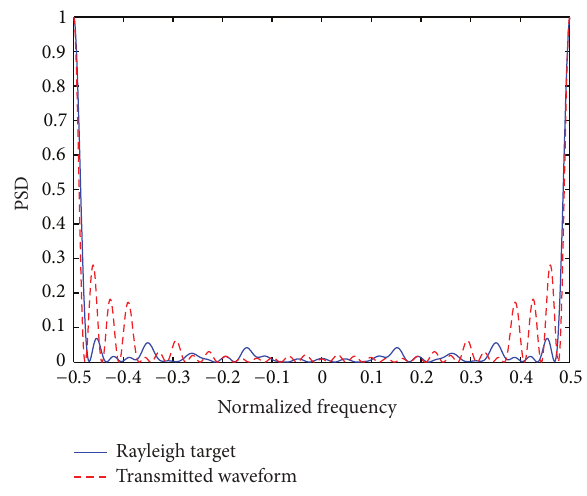
Figure 13: Superposition of PSD of Rayleigh target impulse and transmitted waveform (no clutter).